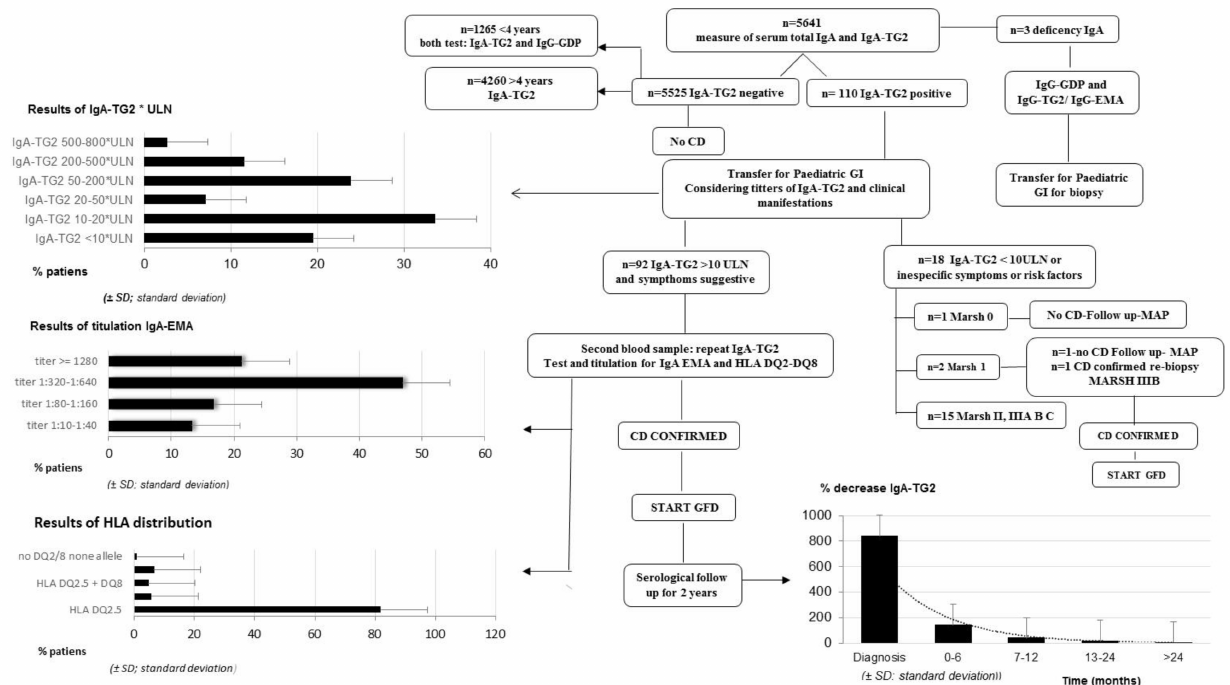
Figure 1. CD diagnosis process with main results. Abbreviations: CD, celiac disease; ESPGHAN, European Society for Pediatric Gastroenterology, Hepatology, and Nutrition; GFD, gluten-free diet; GI, gastroenterologist; HLA, human leukocyte antigen; IgA, immunoglobulin A; IgA-EMA, IgA anti-endomysial antibodies; IgA-TG2, IgA antibodies against tissue transglutaminase Type 2; IgG, immunoglobulin G; IgG-GDP, IgG antibodies against deamidated gliadin peptides; PAD, primary attention doctor; ULN, upper limit of